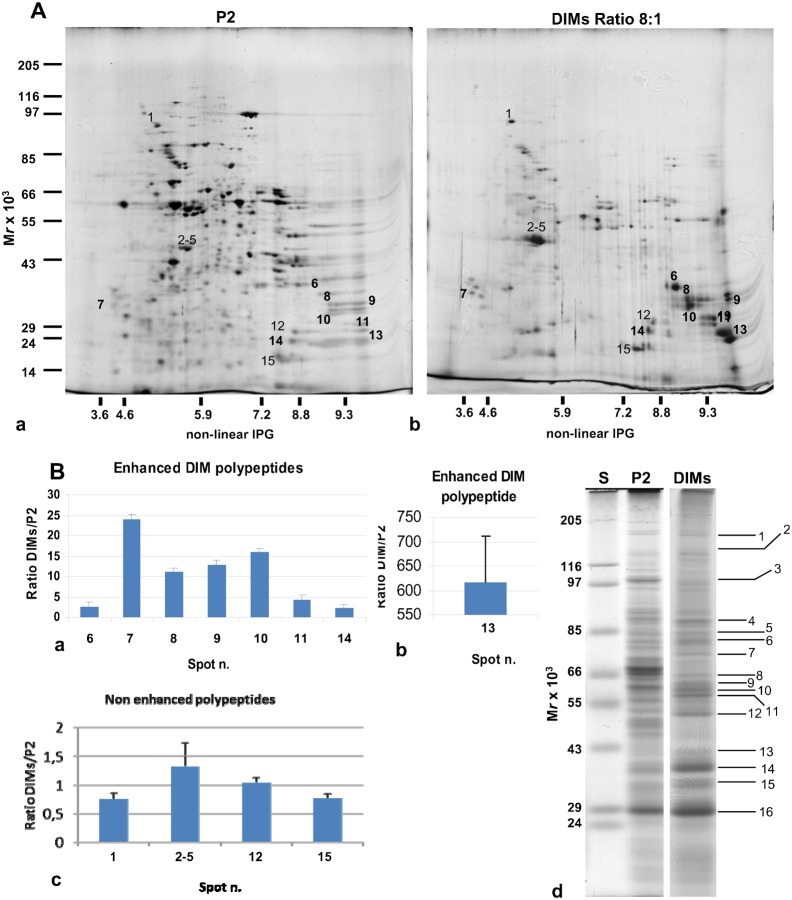
Two-dimensional maps of pollen tube microsomes and DIMs.(A) Representative silver-stained 2D gel electrophoresis of P2 (a) and DIMs (b) from tobacco pollen tubes (30 µg). The corresponding polypeptides, identified by MS-MS analysis, are indicated with normal (not enhanced) and bold (enhanced) numbers. (B) Graphs showing the ratio of enhanced (a,b) and non-enhanced (c) polypeptides identified by MS-MS analysis in DIMs and P2. Error bars indicate standard errors (n = 2). (d) One-dimensional preparatory electrophoresis of pollen tube DIMs (detergent/protein ratio 8:1). 30 µg protein was loaded in the lane. P2 and DIMs were prepared in the same experiment and run in different gels. Polypeptides identified by MS-MS analysis are indicated.